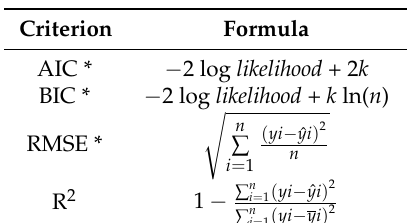
Table 4. Model comparison